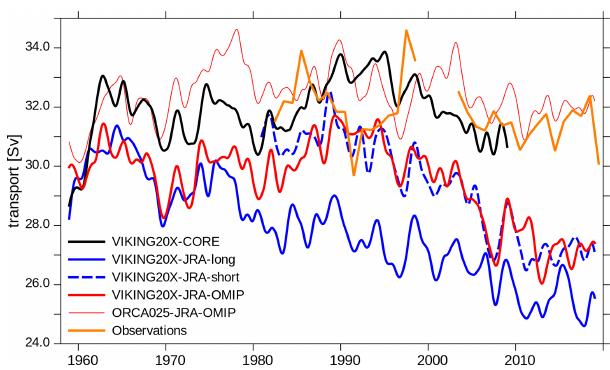
Figure 14. Time series of the transport through Florida Strait from experiments (interannually filtered) and from cable measurements (orange) given as yearly averages for years with data coverage > 70%.